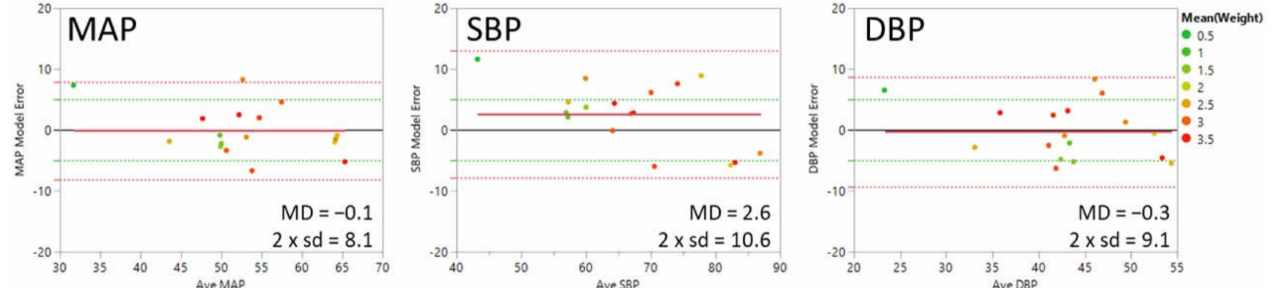
Figure 7. Bland-Altman plots of BP-model-3 results for mean arterial (MAP), systolic (SBP), and diastolic (DBP) blood pressure values in mmHg averaged over each individual. The x -axis is the average of the model and reference blood pressure values. The y -axis is the difference between the model and reference values. The points are color coded for the patients’ weight in kilograms. The red solid line indicates the overall error of the model (Mean Difference (MD)). The dotted red lines indicate 1.96 × the standard deviation (sd). The green dotted lines indicate the MD limits for accuracy of ± 5 mmHg per guidelines from the US Food and Drug Administration.